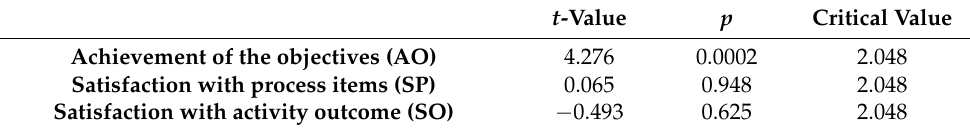
Table 17. t -test obtained values.